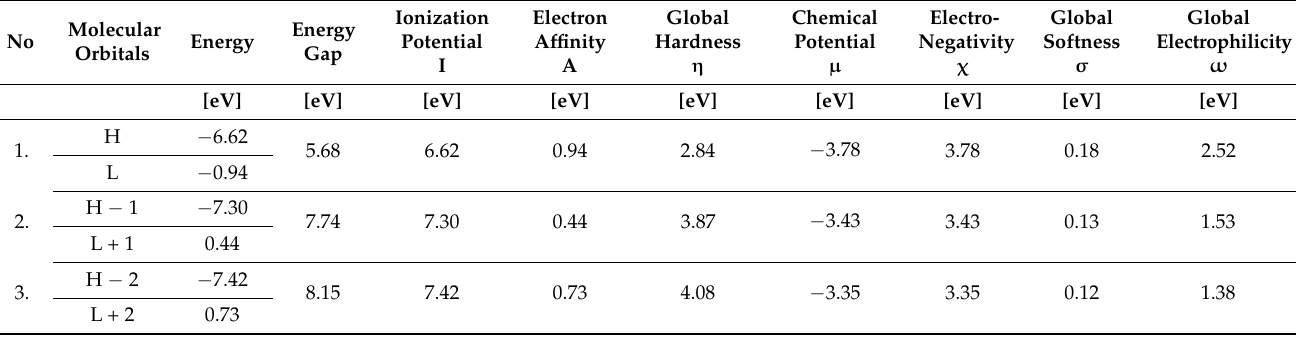
Table 4. The calculated HOMO–LUMO energy gaps and quantum chemical properties of title compound at DFT/B3LYP.